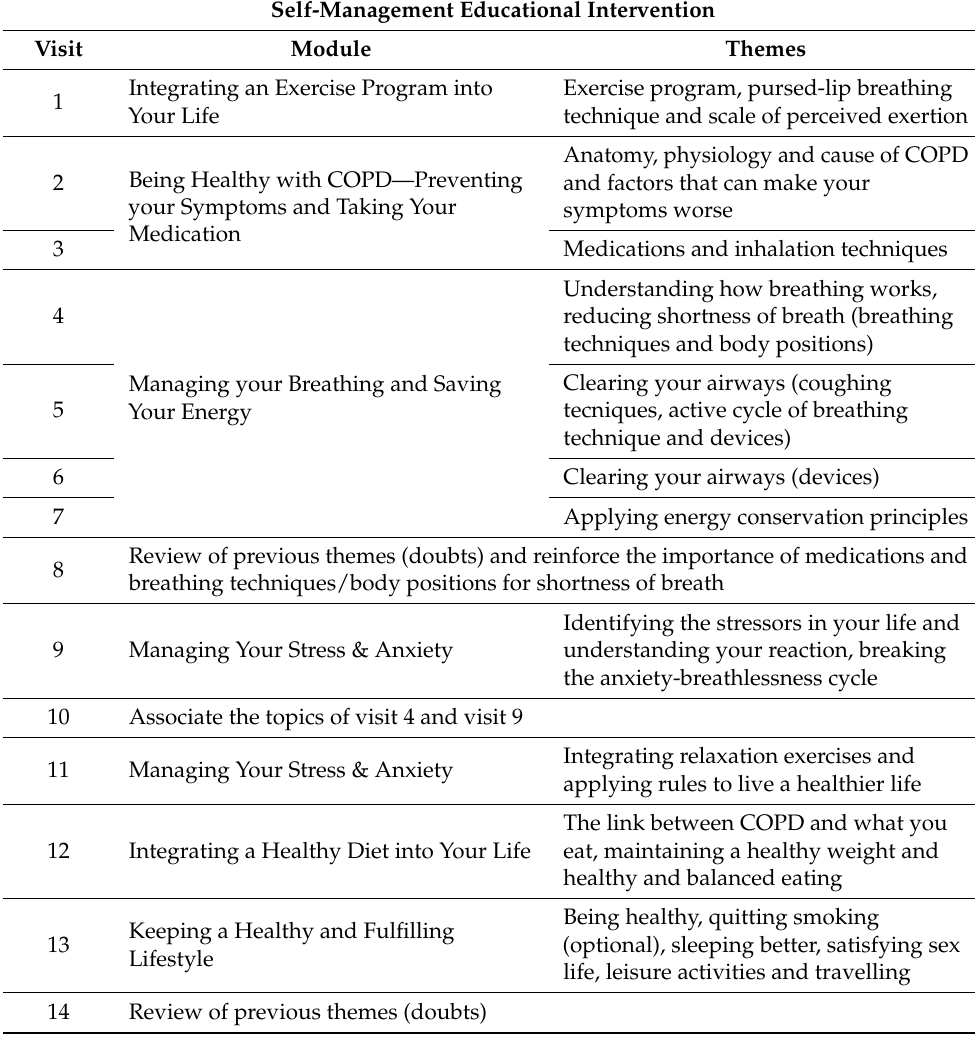
Table 2. Modules and educational topics proposed for the home visits of the intensive phase (14